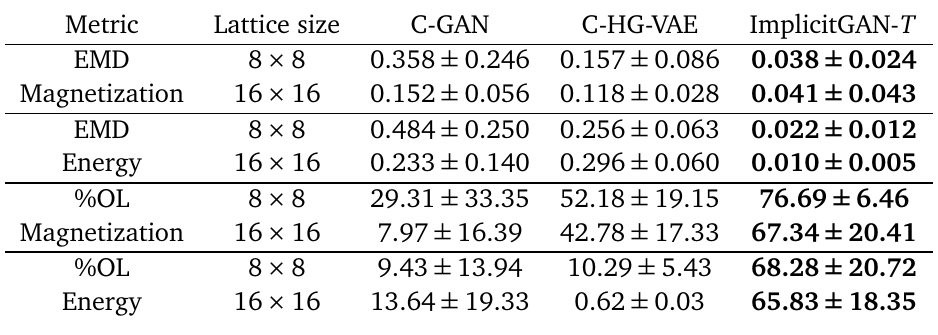
Table 1: Evaluation metrics, as defined in Sec. 4.2, along with standard deviation, computed over 500 configurations and averaged across all temperatures. Smaller EMD and higher %OL are better. Best values are indicated in